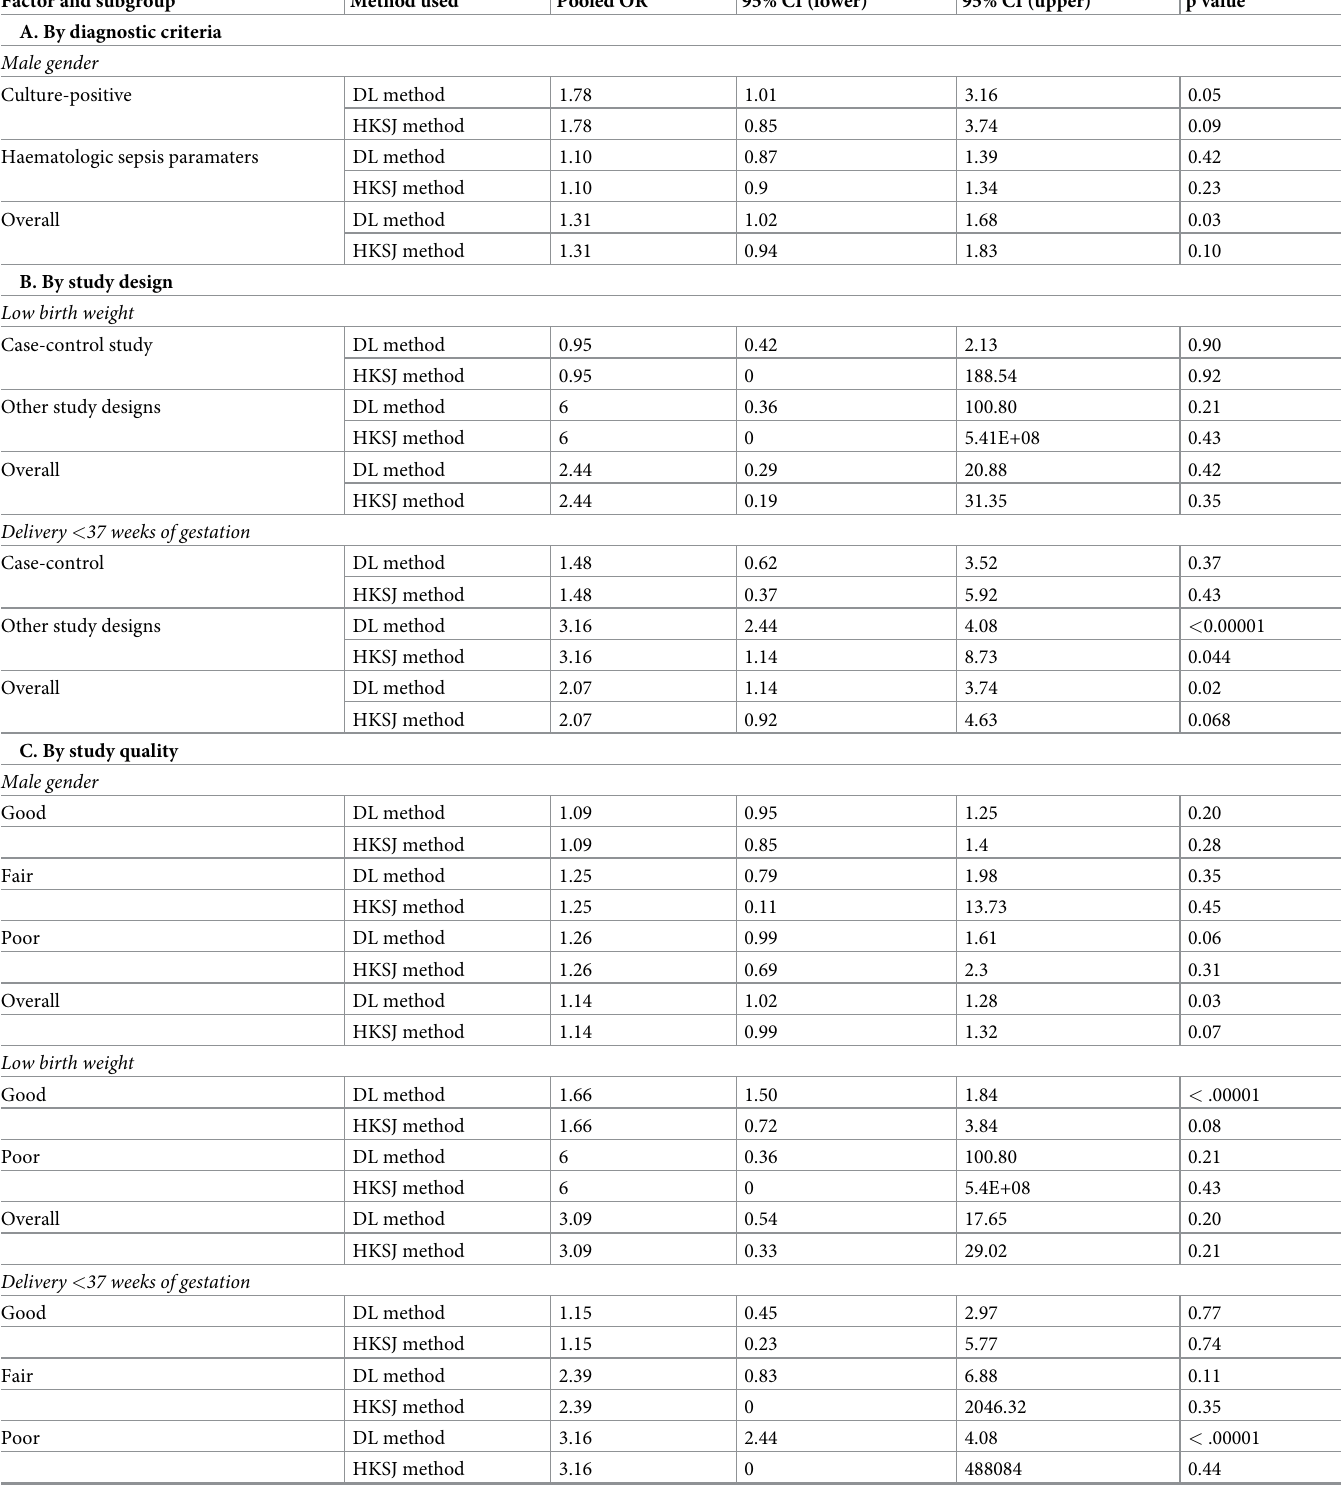
Table 4. Results of subgroup analysis using DerSimonian-Laird (DL) and Hartung-Knapp-Sidik-Jonkman (HKSJ) methods of random-effects meta-analysis. Factor and